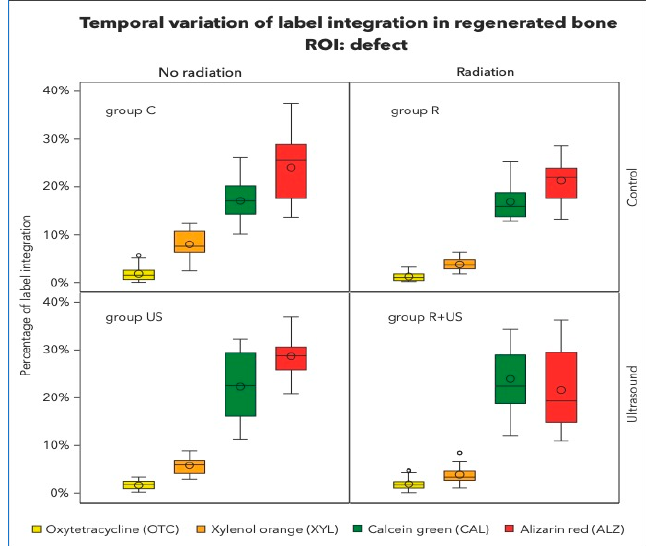
Figure 3. Percentage of label integration into the regenerated bone in the defects, i.e., region of interest (ROI) of each group. Note that the fluorescence spectra of Xylenol orange and Alizarin complexone are very close and hardly detectable to be clearly separated.